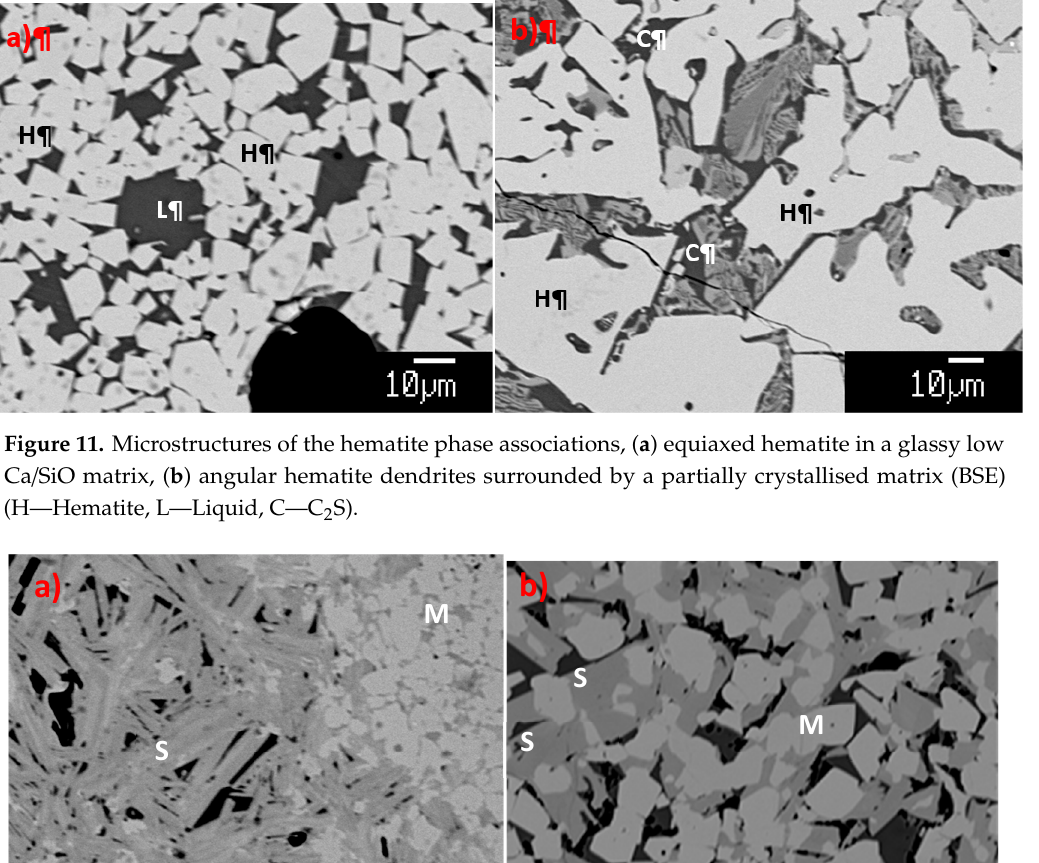
electron images (BSE)).